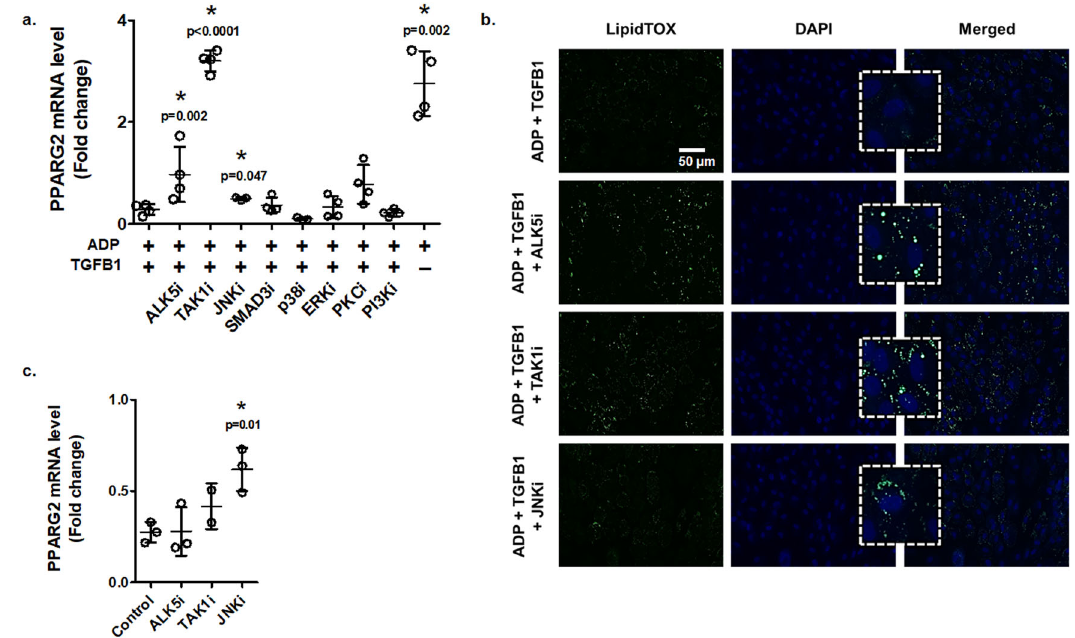
Fig. 6 TAK1-JNK axis mediates TGFB1 signaling to inhibit mesenchymal progenitor cell differentiation into adipocytes. Bone marrow-derived mesenchymal progenitor cells (bm-MPCs) were cultured in adipogenic media (ADP) with TGFB1 (10 ng/mL), and various inhibitors of the TGFB signaling pathway. All inhibitors were tested at 10 µ mol/L concentration and for 72-hour exposure. a Levels of PPARG2 mRNA in bm-MPCs [Data normalized to ACTB , GAPDH , and RPLP0 ; Mean ± SD; n = 4 for all treatments except ADP + TGFB1 + JNKi and ADP + TGFB1 + p38i which were 3; each data point represents an independent sample; two-tailed student ’ s t -test: * p < 0.05 compared with adipogenic media and TGFB1 (ADP + TGFB1)]. b bm-MPCs, treated as indicated in panel a , were stained for intracellular lipid accumulation by LipidTOX (green). Cells were counterstained with DAPI (blue) [scale bar = 50 μ m]. Inserts showing higher magni fi cation. c bm-MPCs cultured in control (DMEM) media supplemented with TAK1 inhibitor (TAK1i; 10 µ mol/L) or JNK inhibitor (JNKi; 10 µ mol/L) for 72 h were analyzed for PPARG2 mRNA levels [Data normalized to ACTB , GAPDH , and RPLP0 ; Mean ± SD; n = 3 control, 3 ALK5i, 3 JNKi, and 2 TAK1i; each data point represents an independent sample; two-tailed student ’ s t -test: * p < 0.05 compared with